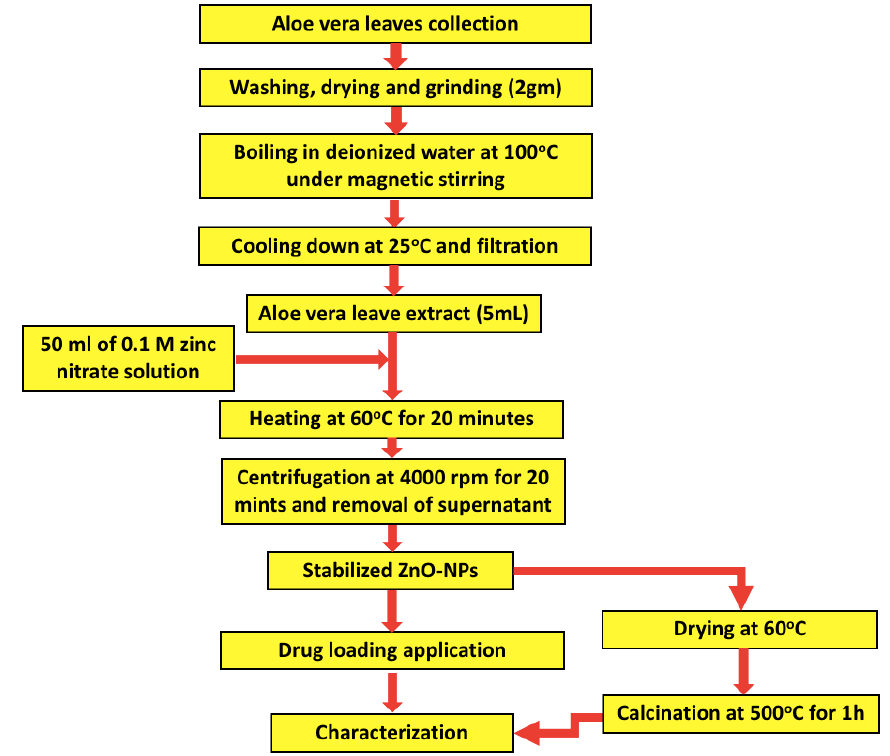
Figure 1. Schematic flowchart of the synthesis process of zinc oxide nanoparticles (ZnO-NPs) using Aloe barbadensis leaf extract.